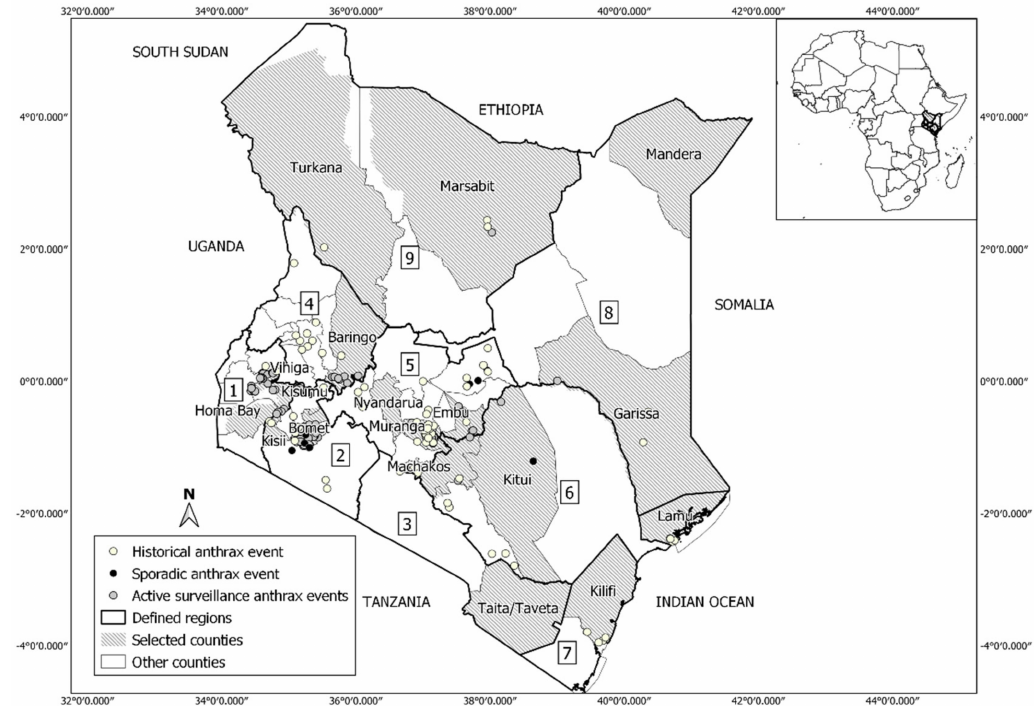
Figure 1. Map of Kenya showing study counties and the spatial distribution of anthrax occurrence data: historical (yellow dots) recorded between 2011 and 2017, sporadic surveys (black dots) recorded between 2018 and 2019, active surveillance (grey dots) recorded between 2019 and 2020. The 18 selected counties represent randomly selected counties stratified on agroecological zones to undertake anthrax outbreak active surveillance. Defined regions 1–9 arbitrarily represent important regions for describing the predicted distribution of anthrax: (1) Lake Victoria basin; (2) Southwestern; (3) Southern; (4) Western; (5) Central; (6) Eastern; (7) Coastal; (8) Northeastern; (9)